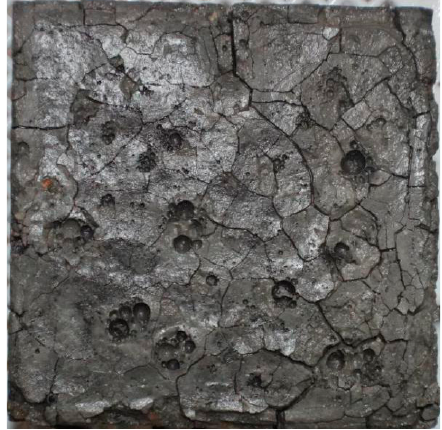
Figure 2. Corrosion cracks on surface of a concrete sample immersed in sodium sulfate solution of 8% concentration for 250 days.